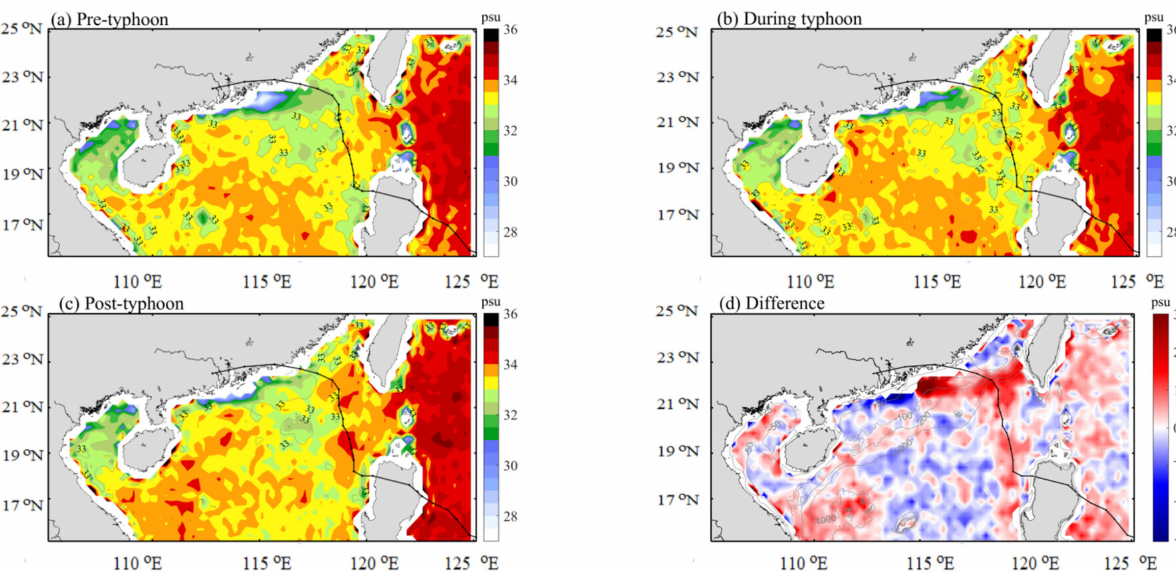
Figure 7. Spatial distribution of sea surface salinity during pre-typhoon ( a ) 1–5 July, during typhoon ( b ) 6–9 July, and post-typhoon ( c ) 10–12 July, and difference ( d ) 10–12 July minus 1–5 July. The gray line represents the water depth (25 m, 50 m, 100 m, 200 m, 1000 m). The black line denotes the typhoon path.